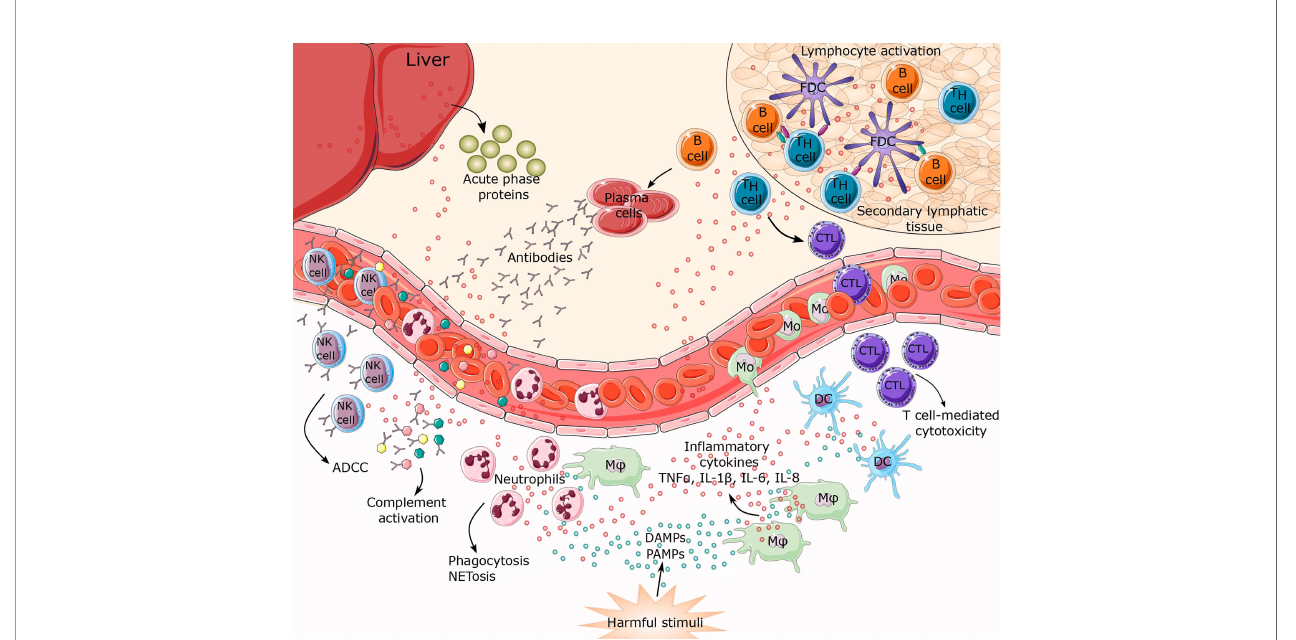
FIGURE 1 | In fl ammatory response to harmful stimuli. When tissue or cellular damage occurs, danger-associated molecular patterns (DAMPS), pathogen associated molecular patterns (PAMPs) and myriad in fl ammatory cytokines (TNF a , IL-1 b , IL-6, IL-8) are released. These biomolecules can initiate activation of in fl ammatory pathways resulting in leukocyte recruitment of innate and adaptive immunity, thus establishing a highly coordinated network of many cell types. Activated macrophages, together with damaged endothelial cells, release factors that attract neutrophils and monocytes to the site of in fl ammation. This represents the fi rst line of defense characterized mostly by phagocytosis and NETosis. Macrophages, together with mature dendritic cells (DCs), are specialized in exposing antigens to lymphocytes (T and B cells), thereby activating antigen-speci fi c adaptive immunity. Lymphocyte differentiation leads to T cell-mediated cytotoxicity, antibody secretion, and antibody dependent cell cytotoxicity (ADCC). Simultaneously, cytokines trigger synthesis and secretion of acute phase proteins from the liver. CTL, cytotoxic T lymphocytes; FDC, follicular dendritic cells; M j , macrophage; Mo, monocyte; NK cell, natural killer